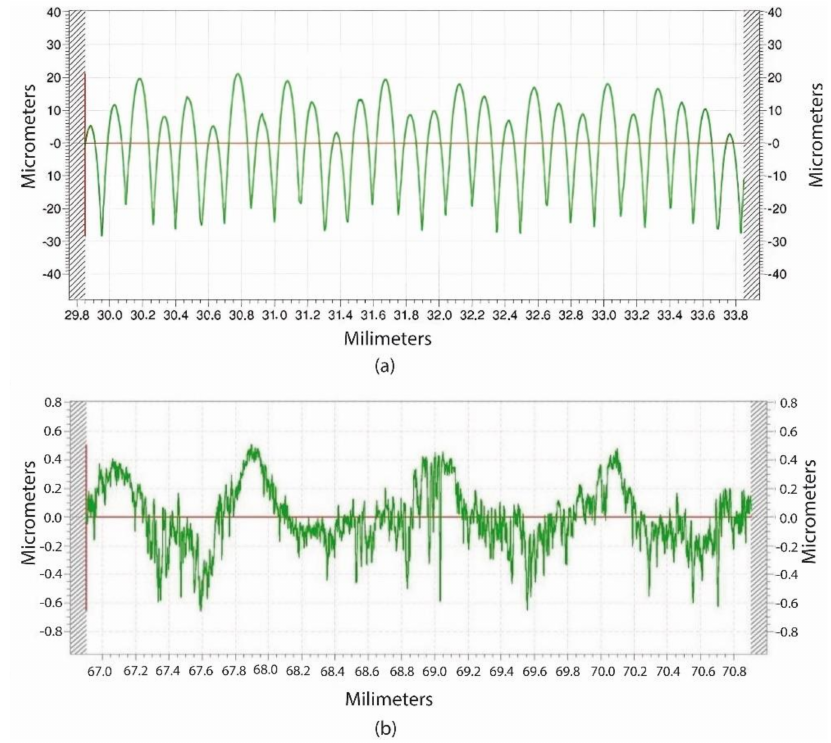
Figure 15. Roughness profile graphs of ( a ) a printed cam and ( b ) a milled